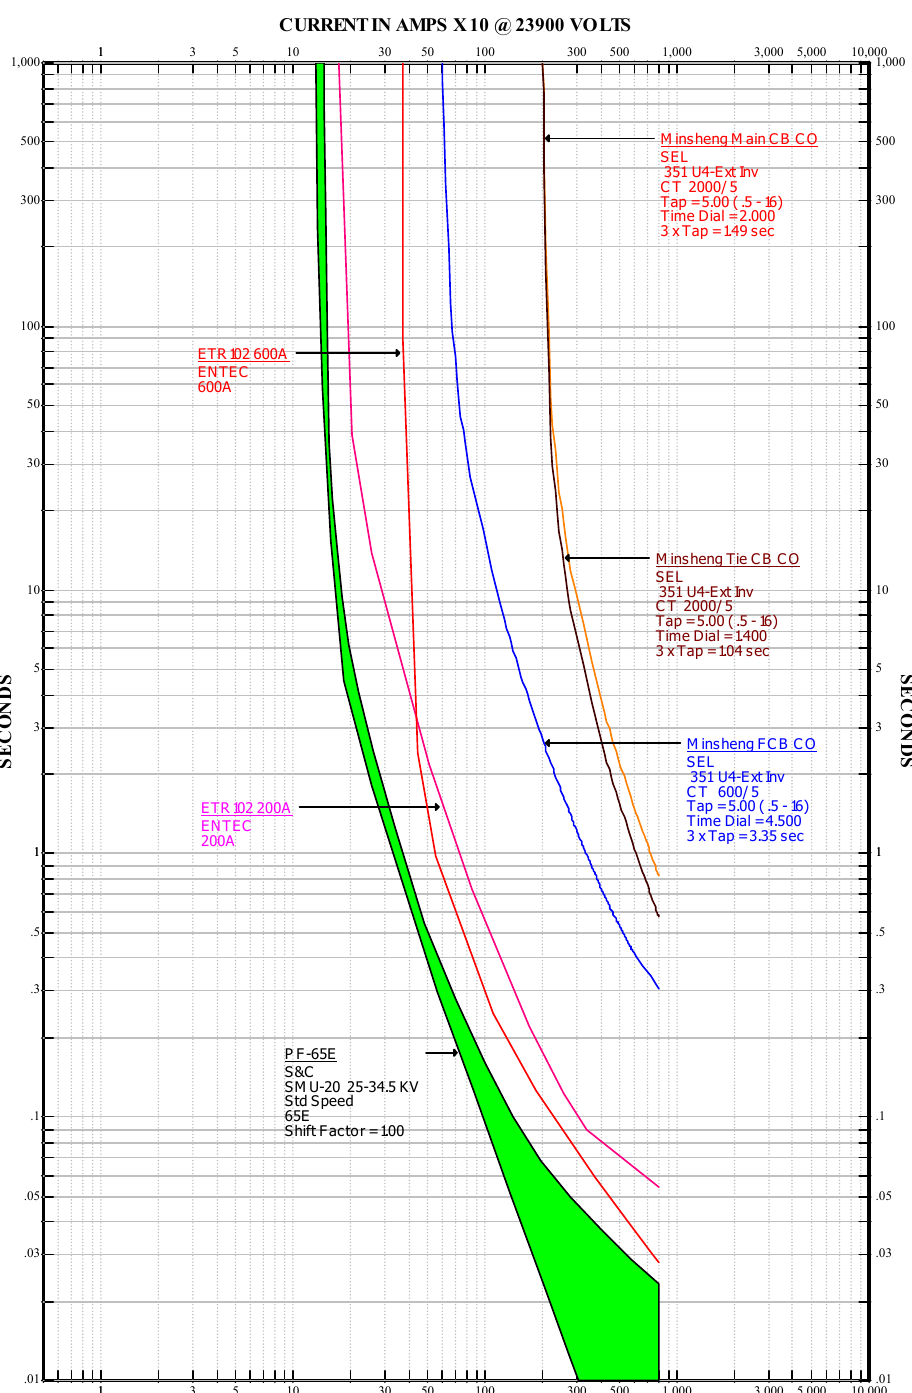
Figure 6. Original CO relays of Minsheng